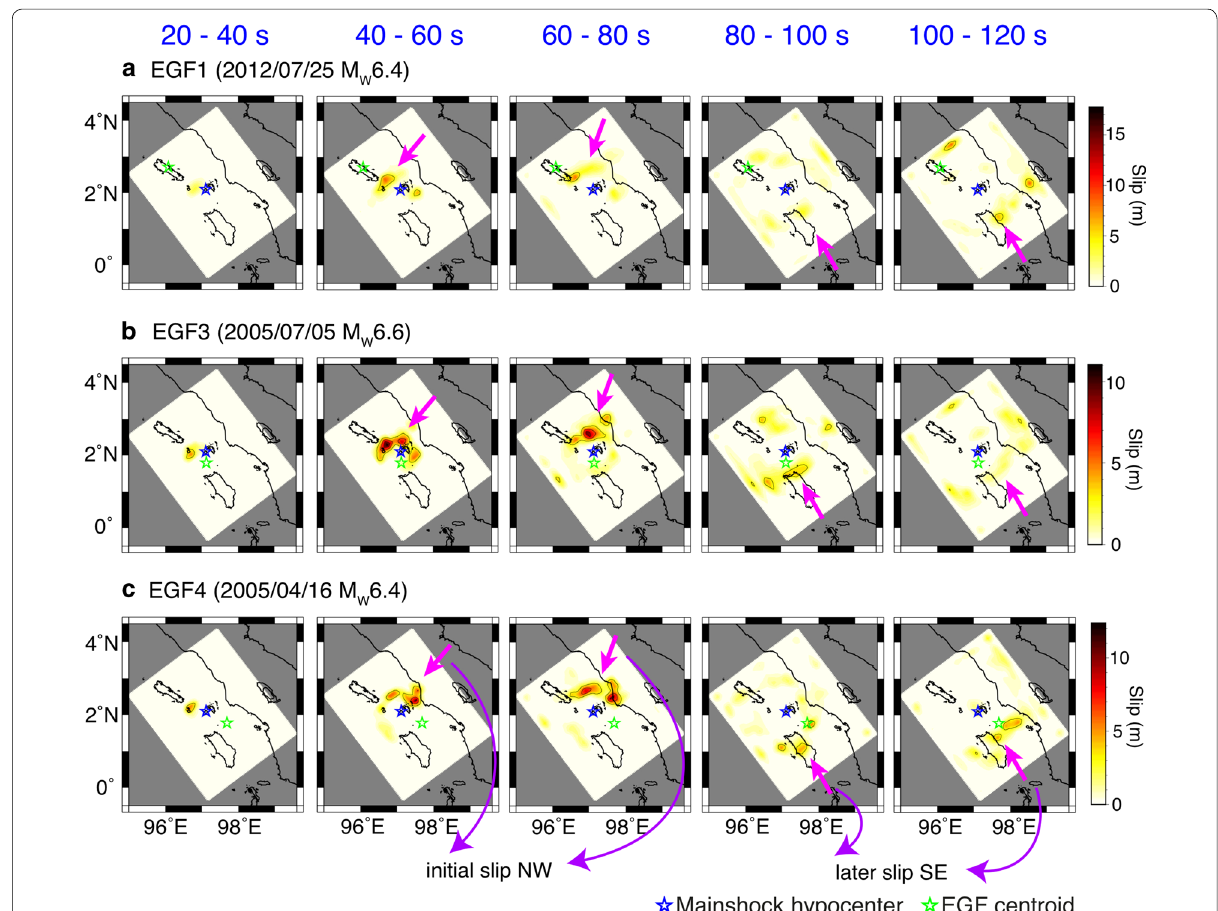
Fig. 5 Comparison of the spatiotemporal slip distribution for the Nias Earthquake using different EGFs. As in Fig. 3, but for the spatiotemporal slip distributions for the Nias Earthquake using a EGF1 (25 July 2012, M W 6.4 ), b EGF3 (05 July 2005, M W 6.6 ), and c EGF4 (16 Apr 2005, M W 6.4 ). Pink arrows indicate notable slip features (see “The 2005 M W 8.6 Nias Earthquake” section for further